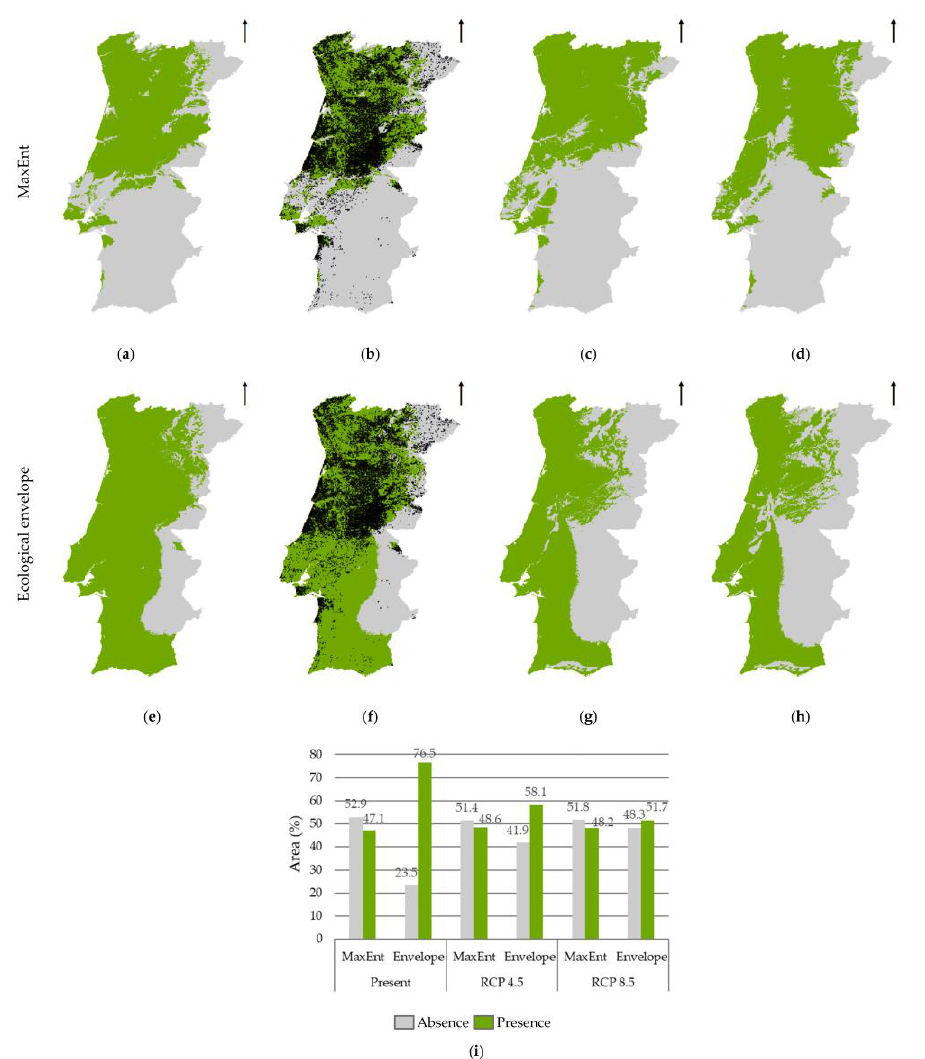
Figure 10. MaxEnt vs. ecological envelope — Maritime pine presence – absence distribution maps ( a ) MaxEnt — Present; ( b ) MaxEnt —Present with the species’ occurrences (black dots); ( c ) MaxEnt – Future (2070) — RCP 4.5; ( d ) MaxEnt — Future (2070) — RCP 8.5; ( e ) Ecological envelope — Present; ( f ) Ecological envelope — Present with the species’ occurrences (black dots); ( g ) Ecological envelope — Future (2070) — RCP 4.5; ( h ) Ecological envelope — Future (2070) – RCP 8.5; and ( i ) Comparison areas (%) under climate change scenarios.